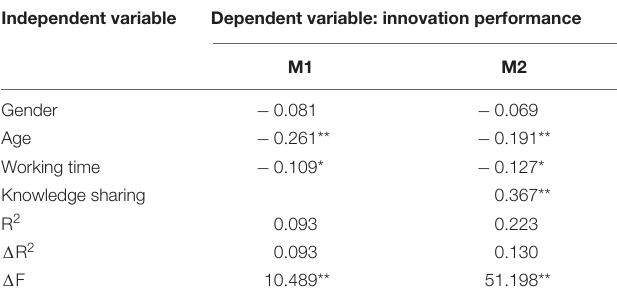
TABLE 4 | Regression analysis of member knowledge sharing on innovation performance.